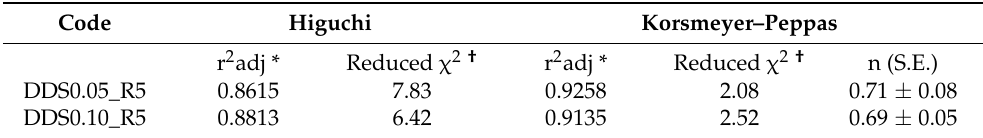
Table 2. Fitting of different kinetic models on the release profiles of different formulations.